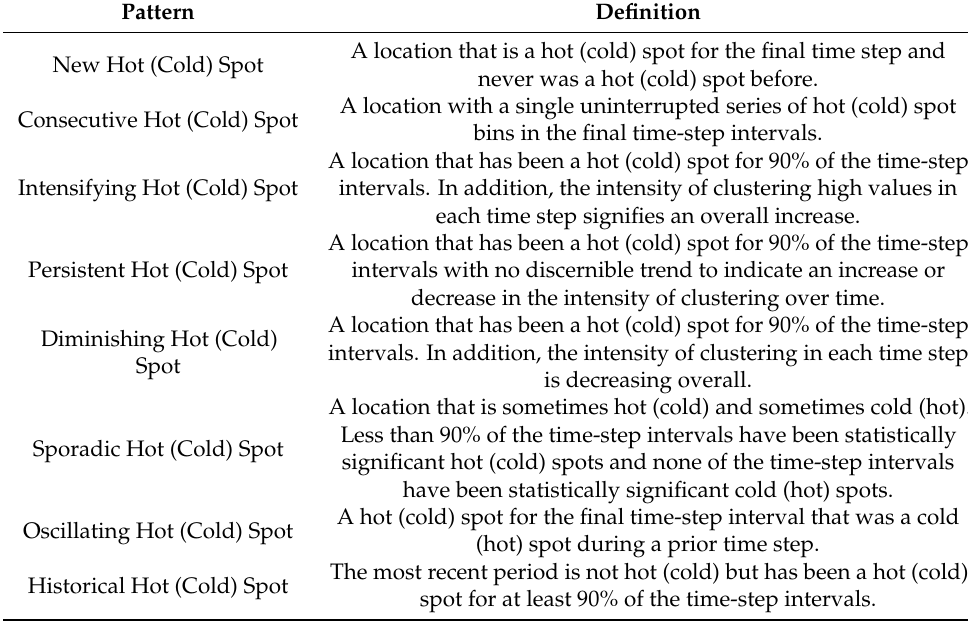
Table 1. The definitions of eight hot (cold) spot